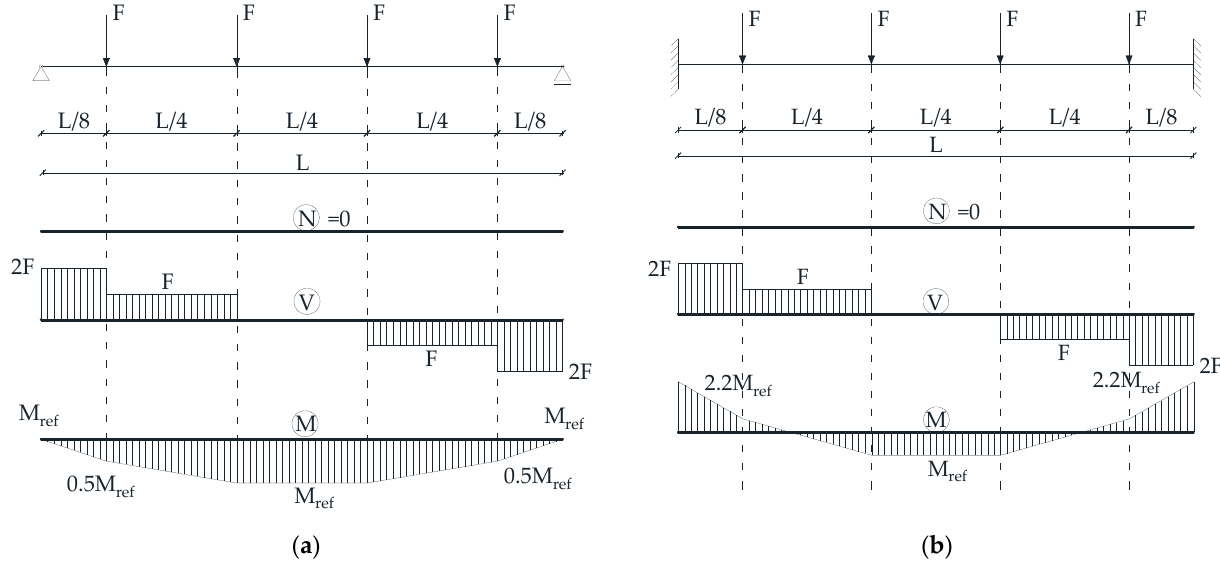
Figure 10. Static systems of analysed solutions: ( a ) pinned supported beam; ( b ) fixed supported beam.